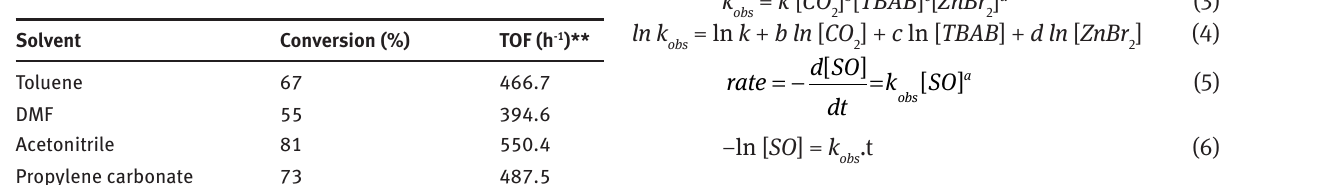
Table 1: Effect of solvent on styrene carbonate (SC) formation cata- lysed by ZnBr /TBAB catalyst.* 2